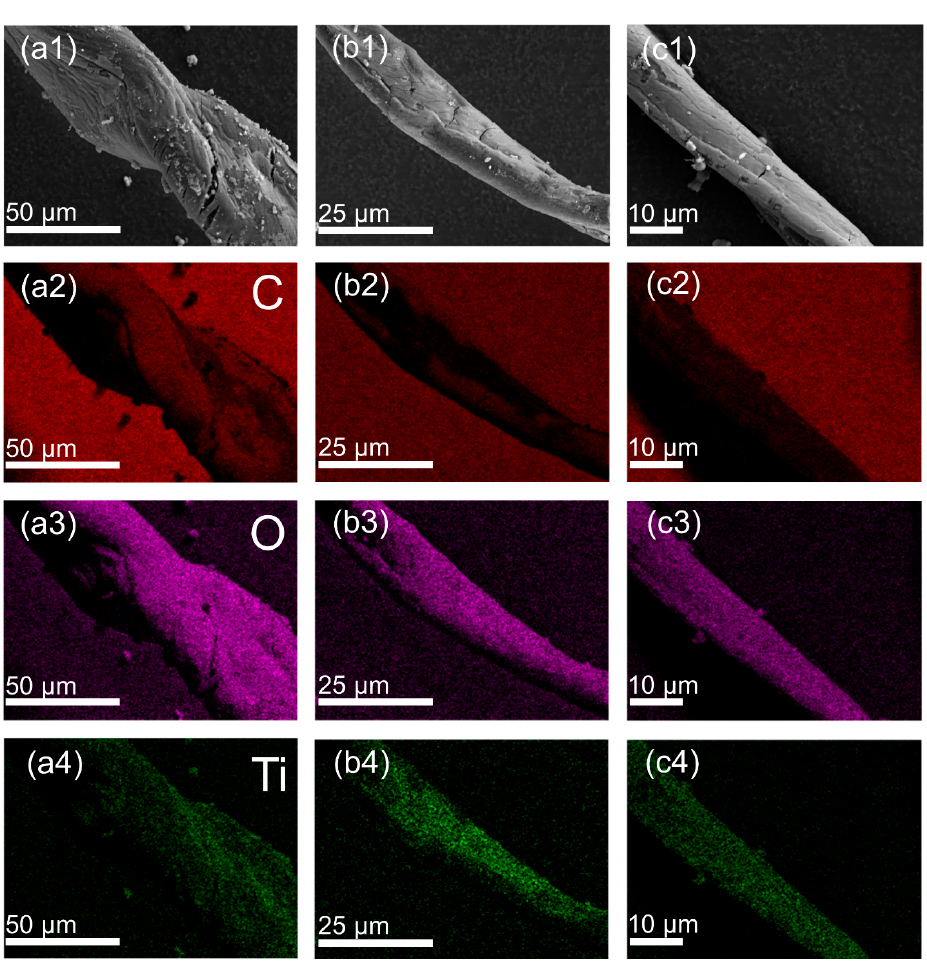
Figure 7. SEM and EDX mapping of TQDs/CC-2.5: ( a1 – a4 ) without photodegradation; ( b1 – b4 ) five recycle tests; ( c1 – c4 ) ten recycle tests.